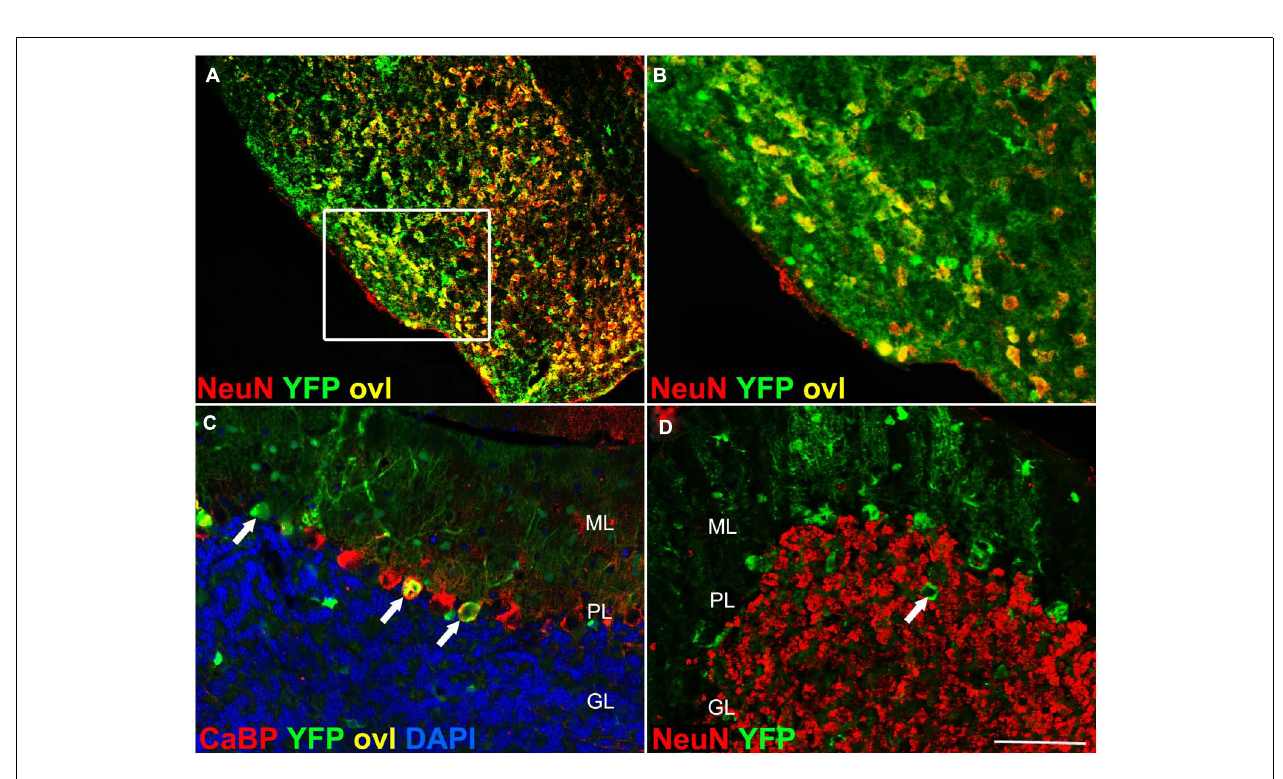
FIGUREA1 | Syn1-Cre is expressed in pontine nuclei but not in cerebellar granule cells. (A) In Syn1-Cre Rosa26-YFP mice,YFP immunoreactivity is detected in pontine nuclei (inset magnification in B ). In the cerebellum,YFP immunoreactivity (arrows in C ) is detected in calbindin + Purkinje cells (arrows